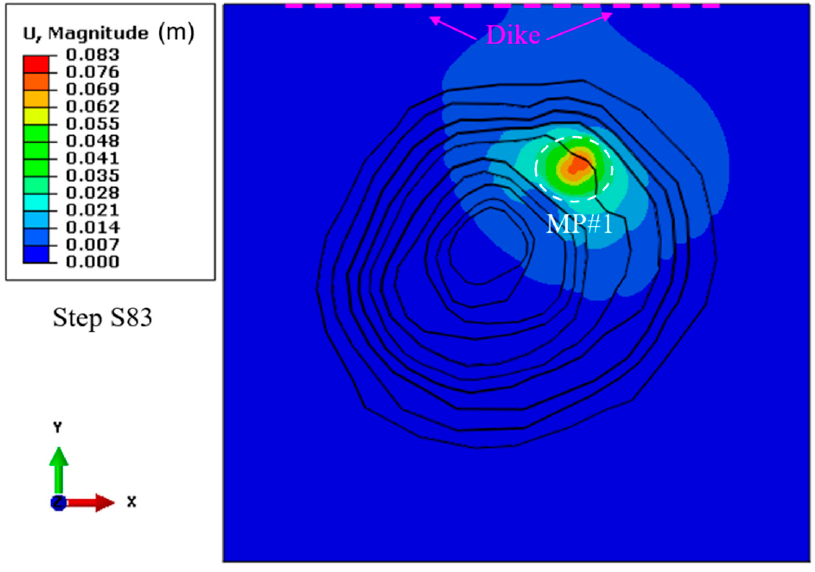
Figure 2. The open pit bench at the mine [30]. The profile of the computed displacement of the open pit slopes in the FE model is shown in Figure 3. The main areas with maximum ground settlement are over the mining pipe MP#1, where the mining activities are in active production. Though the three mining blocks were backfilled with cemented rockfill (CRF), the open pit boundary in the developed model, where the dike is located, still sees a tiny increase in displacement after the completion of the excavation and backfilling of the three mining blocks. The stability and safety of the protective dike play a significant role in mine site safety.